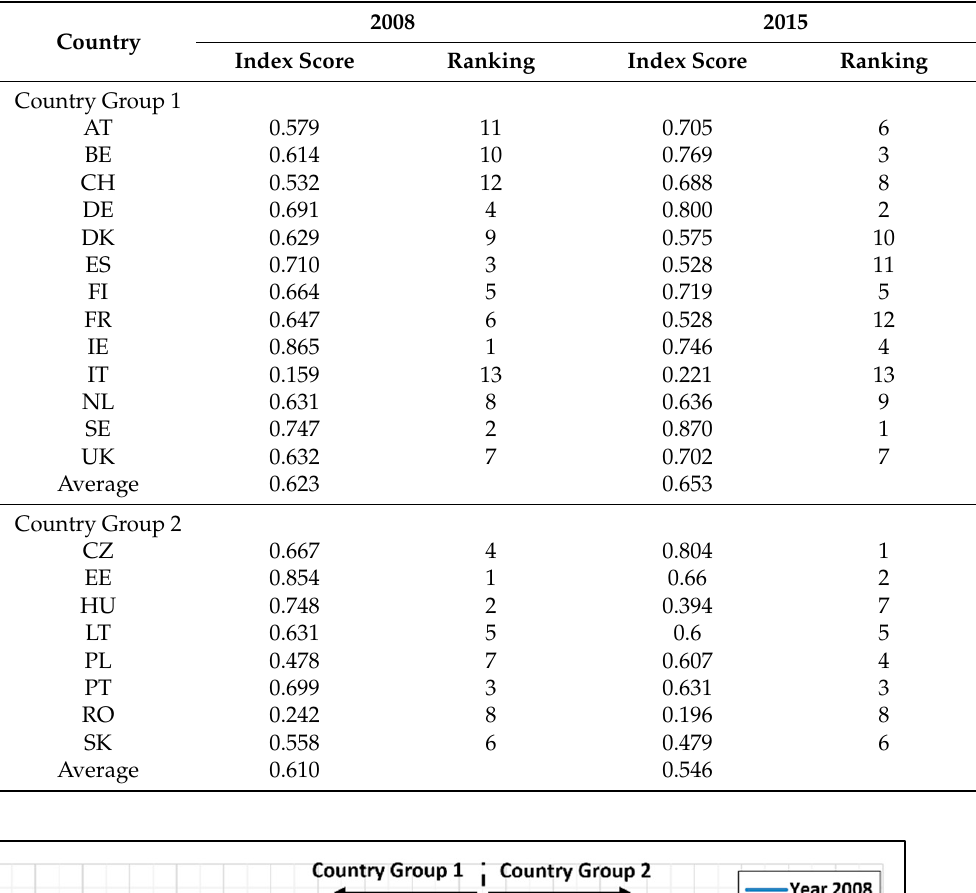
Table 4. Index scores and corresponding rankings of countries within each group for different years.